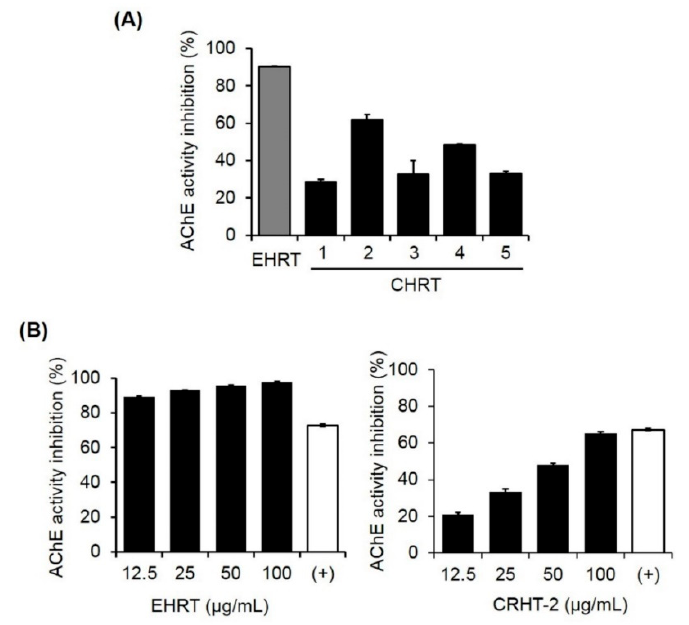
Figure 1. Inhibitory effects of the ethanol extract of Hwangryunhaedok-tang (EHRT) and five commercial HRT granules (CHRTs 1–5) on acetylcholinesterase (AChE) activity. The AChE activity assay was performed using a modified Ellman’s colorimetric method. The enzymatic reaction was performed by incubating the mixture of AChE solution with ( A ) EHRT or CHRTs 1–5 (100 µ g/mL); ( B ) EHRT (12.5, 25, 50, or 100 µ g/mL) (left panel); and CHRT-2 (12.5, 25, 50, or 100 µ g/mL) (right panel) for 1 h at room temperature. Absorbance was measured at 412 nm using an Epoch microplate spectrophotometer (Bio-Tek Instruments, Winooski, VT, USA). Berberine (500 nM) was used as a positive control (+). Each value is presented as the mean ± standard error of the mean (SEM) ( n = 3).